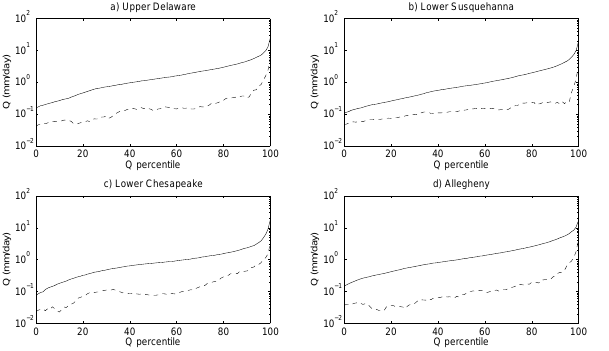
Fig. 7. Hydrograph comparison of the two selected catchments for water year 1973 within (a) Upper Delaware, (b) Lower Susque- hanna, (c) Lower Chesapeake, and (d) Allegheny